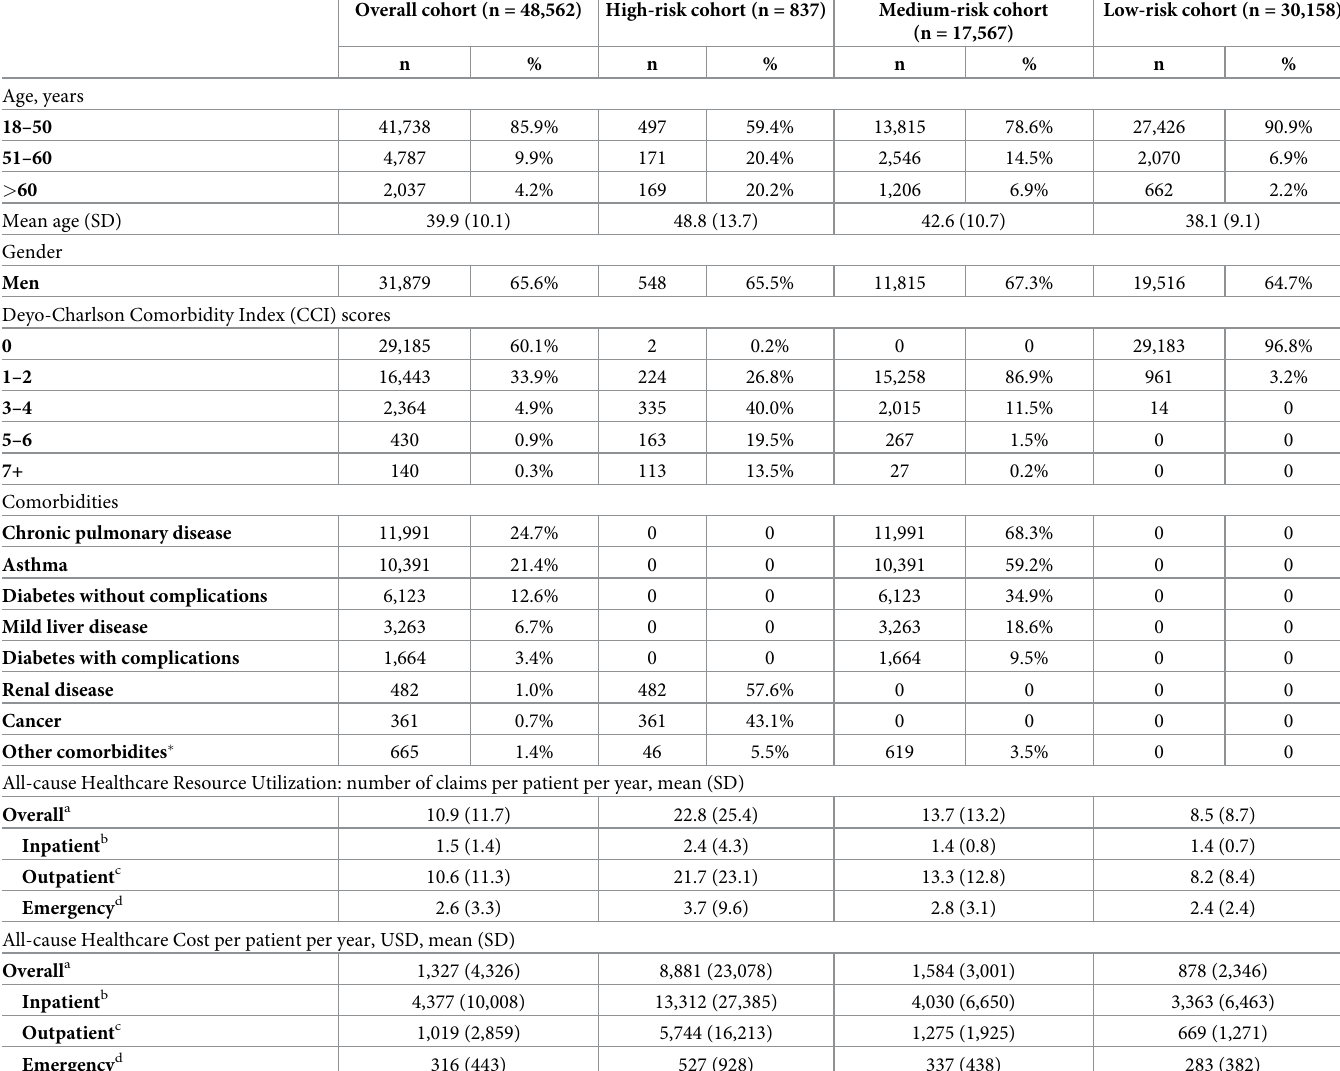
Table 1. Baseline demographics, clinical characteristics, healthcare resource utilization and associated costs during pre-index period (patients having at least one claim for pneumonia during identification period were included in the analysis; Dubai Real-World Claims Database, 2014 to 2019). Overall cohort (n = 48,562) High-risk cohort (n =